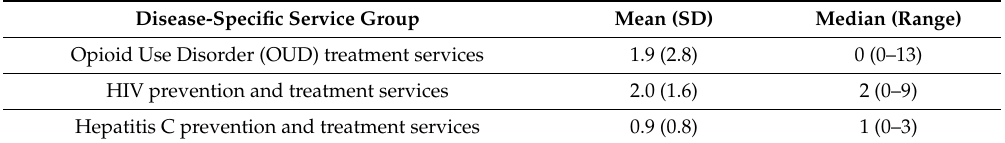
Figure 3. HIV prevention and treatment services at local health department services per 100,000 population by tertiles, respondent rural counties, Illinois, 2018: ( A ) crude rates; ( B ) empirical Bayes estimated rates.